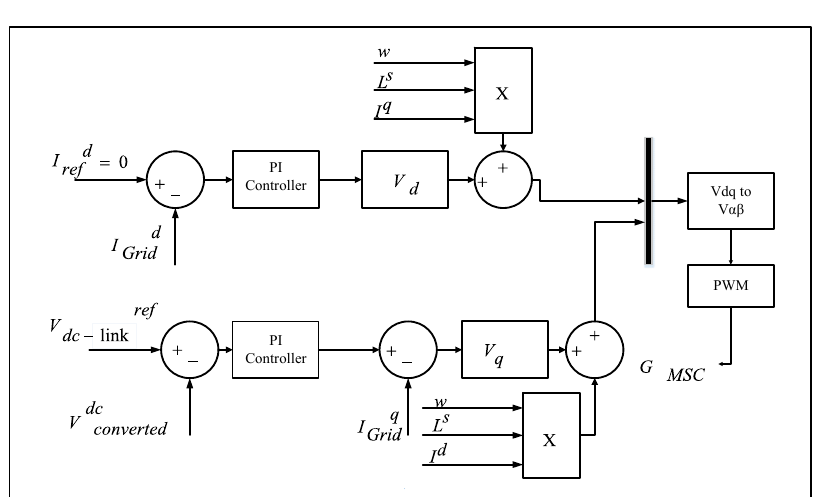
Figure 1. Conventional machine side control.